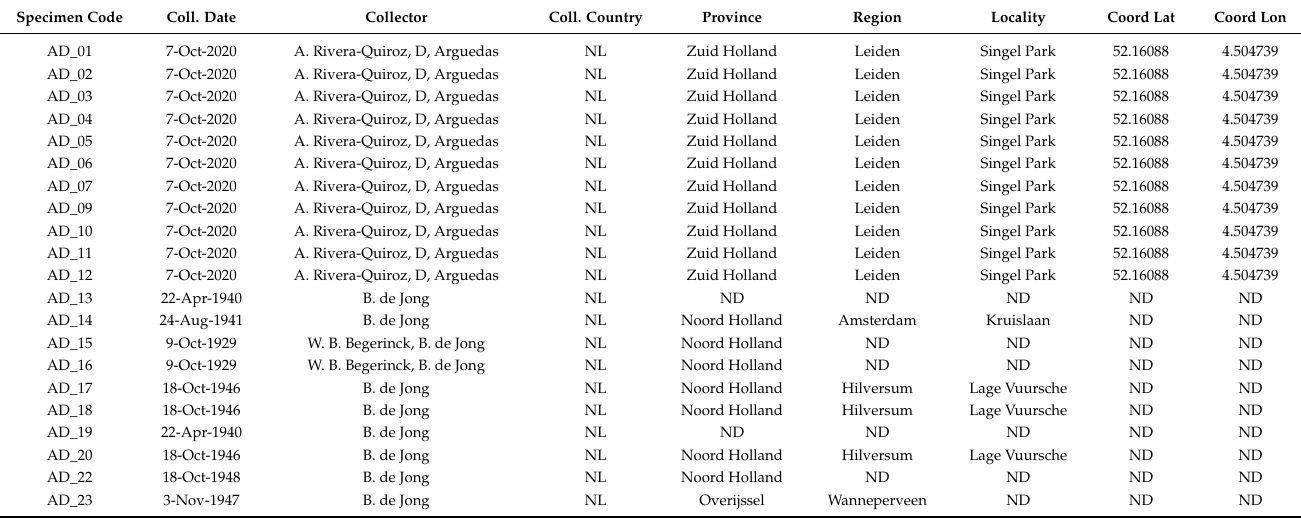
Table 1. Data of the freshly collected and legacy specimens used in our